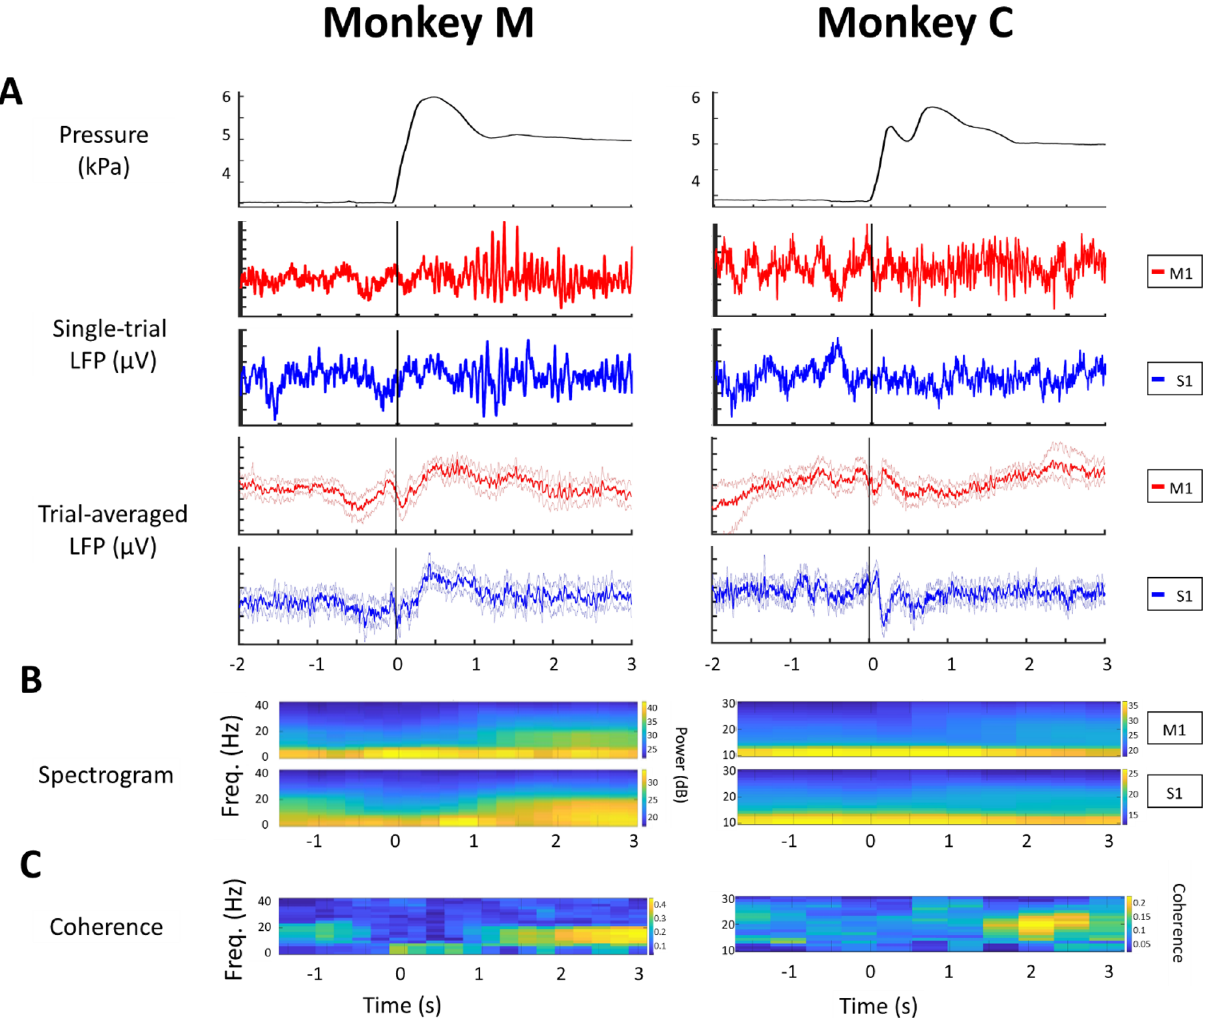
Figure 2. Single LFP S1-M1 channel pair activity in the ‘NORMAL’ reach-and-grasp task. All trials were aligned to the onset of touch (t = 0). Left: Monkey M. Right: Monkey C. ( A ) Upper panel: Example of the typical pressure profiles showing similar temporal force patterns applied by each animal: An initial overshoot from 0 to 1 s, followed by a stable isometric force (steady-state). Middle panels: LFP signals recorded from one M1 and one S1 channel showing the beta-band activity during steady-state. Lower panels: Trial-averaged LFP response on one channel for both S1 and M1 signals showed modulation at the onset of touch (bootstrap resampling, the number of resamples is 1000). The bold red and blue lines showed the mean of LFP amplitude across trials and the shaded regions denoted 95% confidence interval of the data (n = 51 trials collected in 3 sessions for monkey M and n = 86 trials collected in 3 sessions for monkey C). ( B ) Trial-averaged LFP spectrogram during the ‘NORMAL’ task showing downmodulation at the onset of touch and increased beta activity in steady state. Upper panel: M1 spectrogram. Lower panel: S1 spectrogram. ( C ) Spectra-temporal S1–M1 LFP coherence shown as a heat map, highlighting the beta coherence (Random permutation test, #permutation = 200, p = 10 –2 ) during the steady state. Note that the beta-band in Monkey M from 13 to 16 Hz, and monkey C from 23 to 30 Hz Beta oscillations in S1 and M1 during the ‘NORMAL’ task.